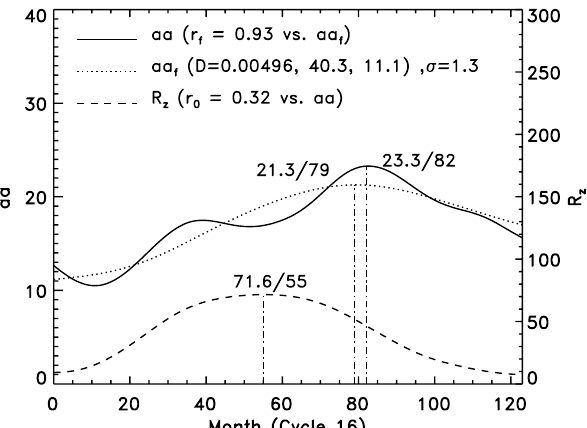
Fig. 5. Results for Cycle 16 (from April 1923 to July 1933), aa (solid), R z (dashed), and the reconstructed series aa f (dotted) from Model (10). The correlation coefficients of aa with R z and aa f are r 0 = 0 . 32 and r f = 0 . 93, respectively. The peak sizes/time intervals (in months) of these peaks from the minimum are also labelled.